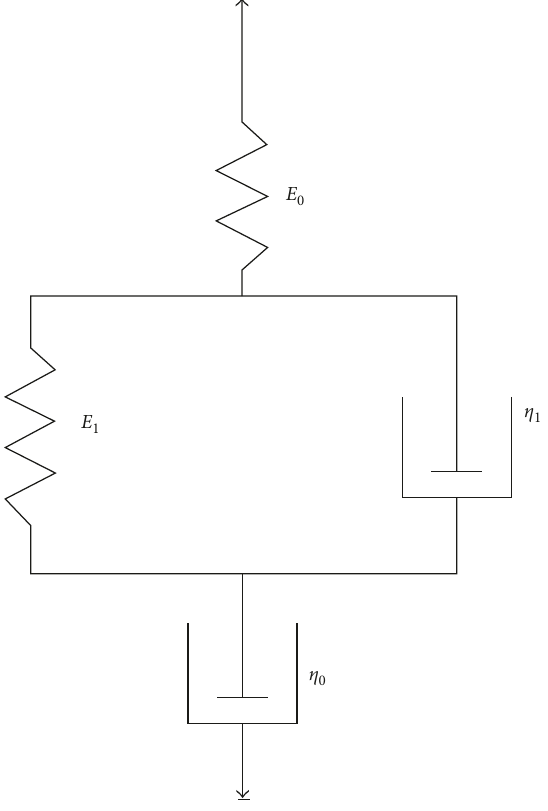
Figure 13: The Burgers